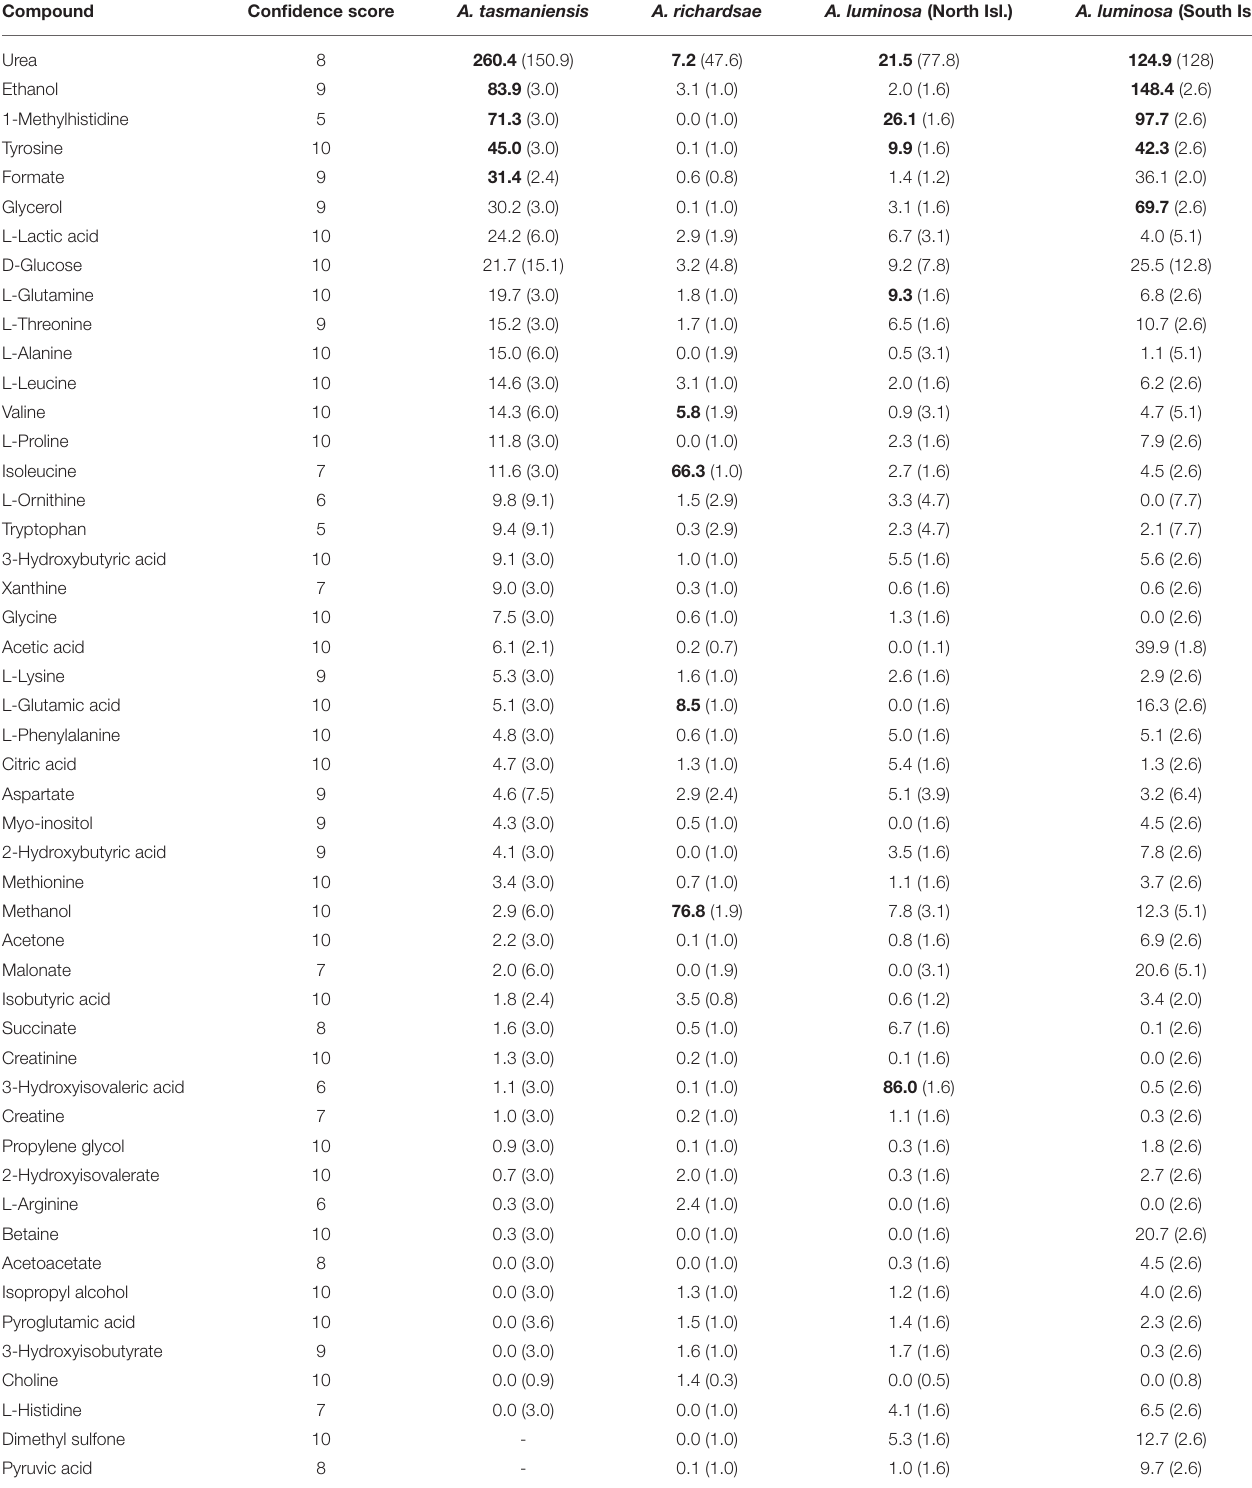
TABLE 1 | Summary of compounds identified from the water soluble fraction of glowworm glue droplets with solution state 1 H NMR spectroscopy.